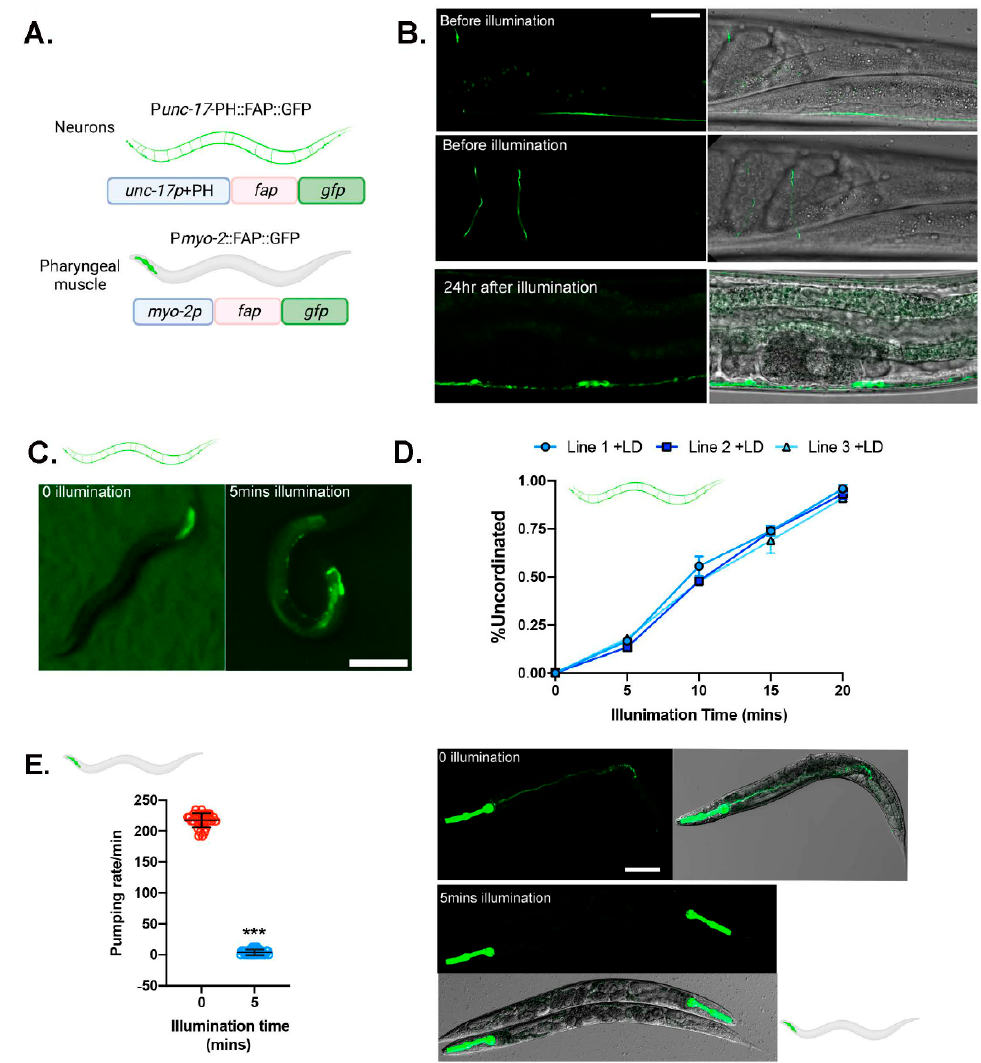
Figure 3. Chemoptogenetic tool can be used to induce oxidative damage in a spatial manner ( A ) Schematic of constructs targeting FAP to cholinergic motor neurons and pharyngeal muscle in bus- 5. ( B ) Images of cholinergic motor neurons (GFP) before and 24 hr after illumination. Morphological changes, including absence of motor commissures and appearance of punctae, are visible after illumination. Scale bar = 25 µ m ( C ) Representative images of unc-17p::ph::fap::gfp transgenic bus-5 worms immediately after red light illumination. ( D ) Percentage of Unc animals after 24 hr MG-2I dye soak and immediately after red light illumination for the indicated times. ( E ) Pharyngeal pumping rate of myo-2p::fap::gfp in bus-5 , fed OP50 was quantified before and after 24 hr MG-2I dye soak and immediately following 5 min illumination with far-red light. Pumping rate was measured in the terminal bulb. A total of 3 independent experiments were performed. Pumping rate was plotted as mean ± SD. Pumping rate was determined from the mean of 10–12 worms for each experiment. Unpaired t -test was performed. *** p < 0.001. ( F ) myo-2p::fap::gfp were fed OP50-GFP for 30 min, followed by 24 hr MG-2I dye soak and 5 min illumination. Brightly fluorescing Escherichia coli (E. coli) OP50-GFP bacteria observed in digestive tract towards the tail in non-illuminated worms, but absent after exposure to light. Scale bar = 90 µ